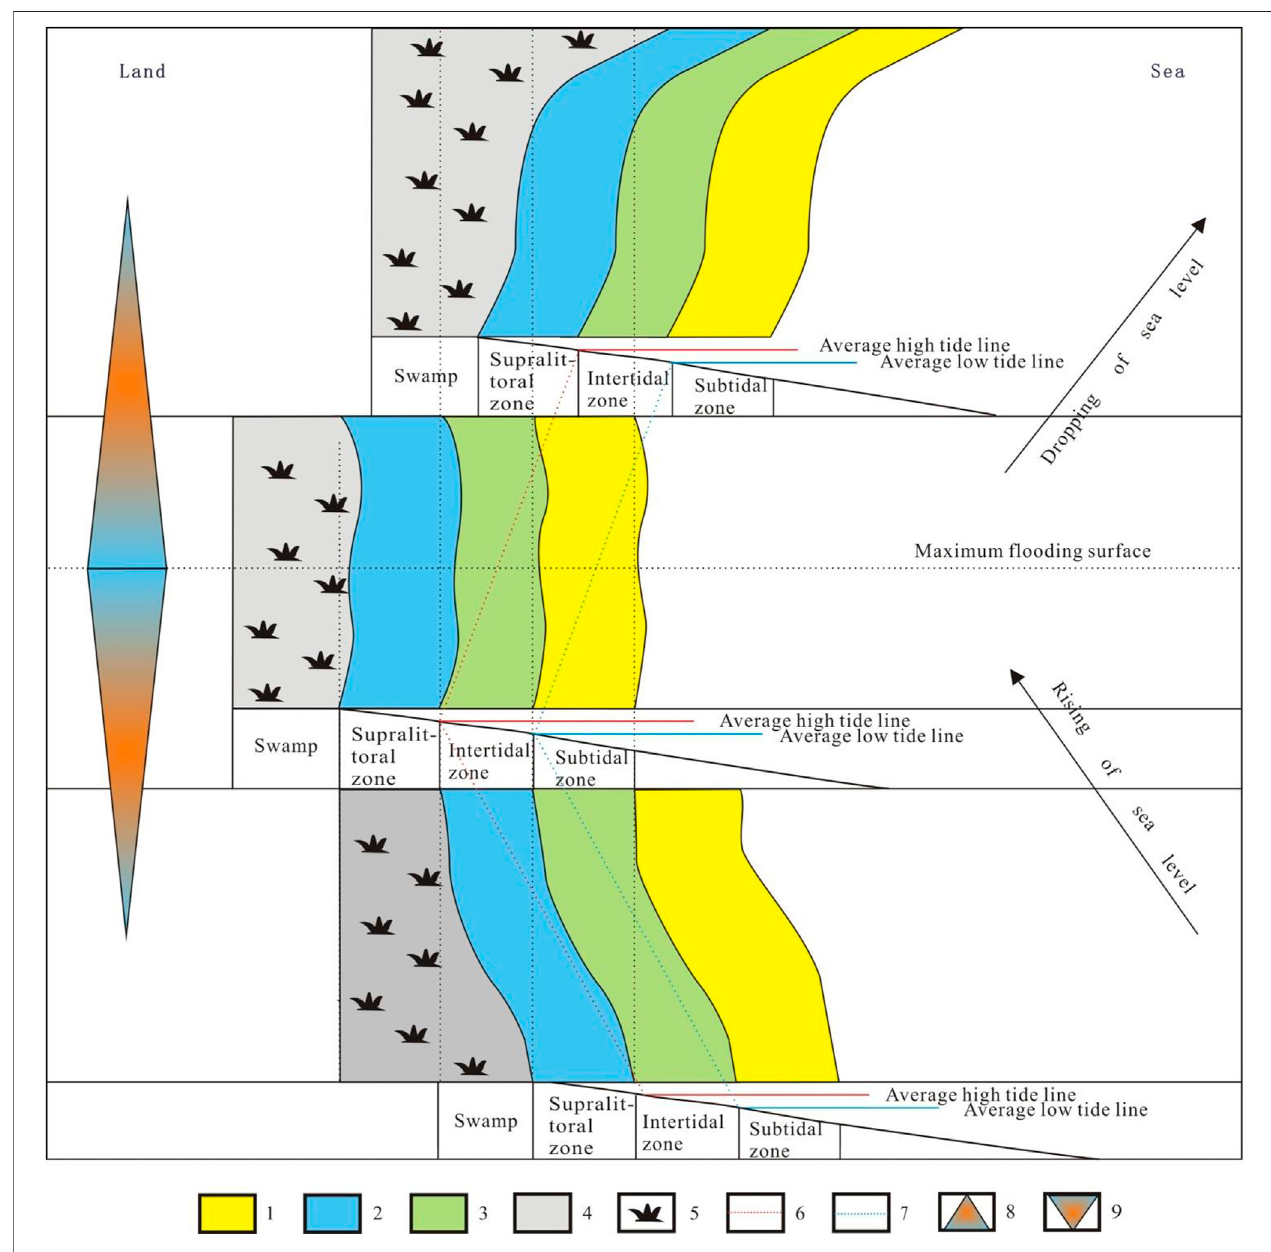
FIGURE 2 | Trends of tidal fl ats and lithology varying with sea level. 1. Sand fl at; 2. Mud fl at; 3. Mixed fl at; 4. Swamp; 5. Vegetation; 6. Curve of change in average high tide line; 7. Curve of change in average low tide line; 8. Fining-upwards sequence; 9. Coarsening-upwards sequence.